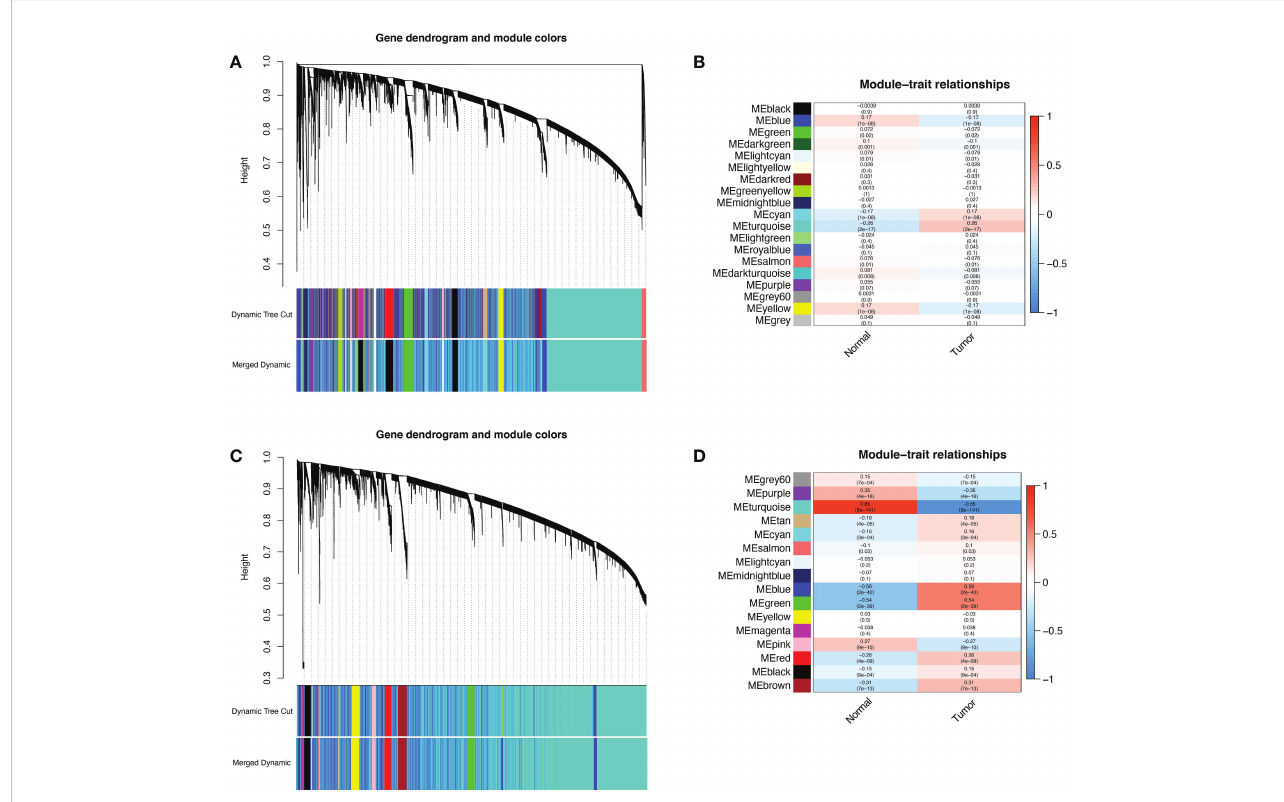
FIGURE 1 WGCNA of ER/PR-positive breast cancer and EEC. (A) The cluster dendrogram of ER/PR-positive breast cancer. (B) Correlation of WGCNA modules and ER/PR-positive breast cancer. (C) The cluster dendrogram of ER/PR-positive breast cancer. (D) Correlation of WGCNA modules and EEC. WGCNA, weighted gene co-expression network analysis. ER, estrogen receptor; PR, progesterone